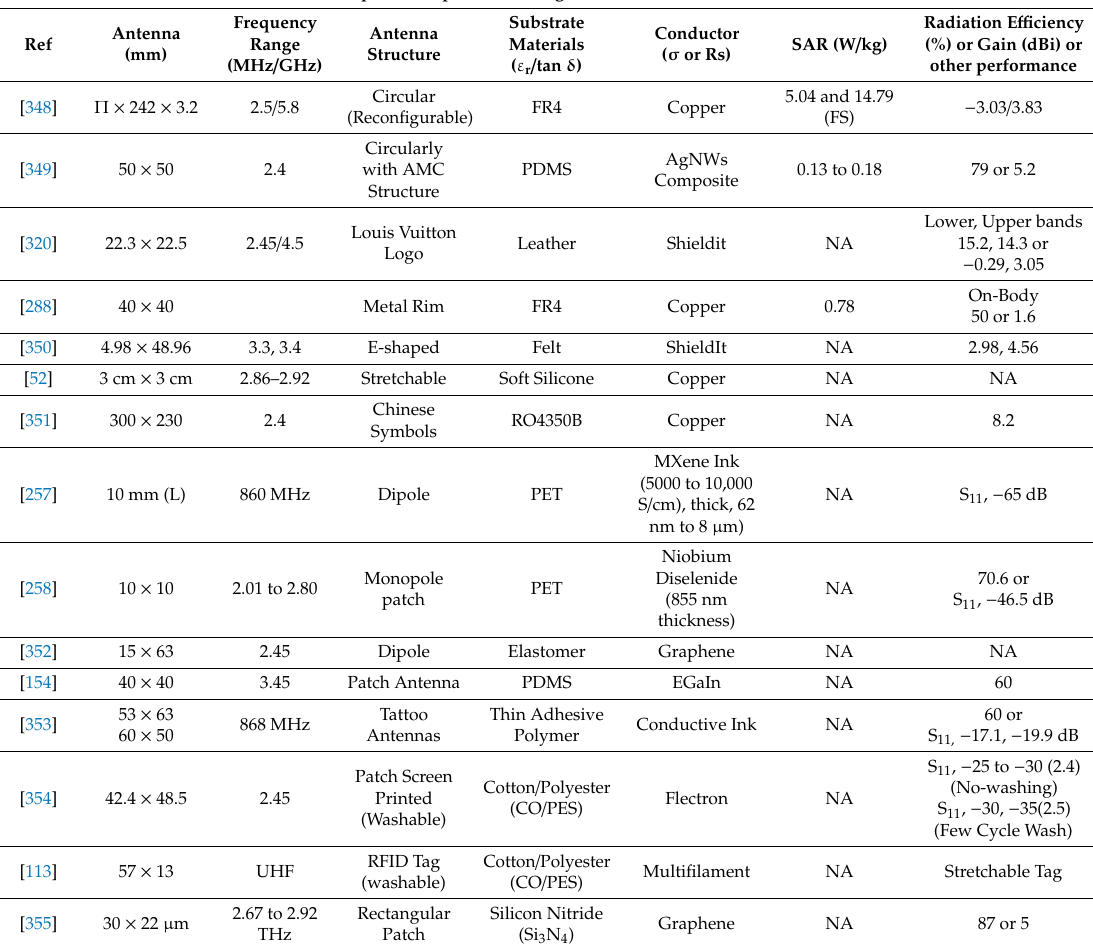
Examples: Comparison of Single and Multiband